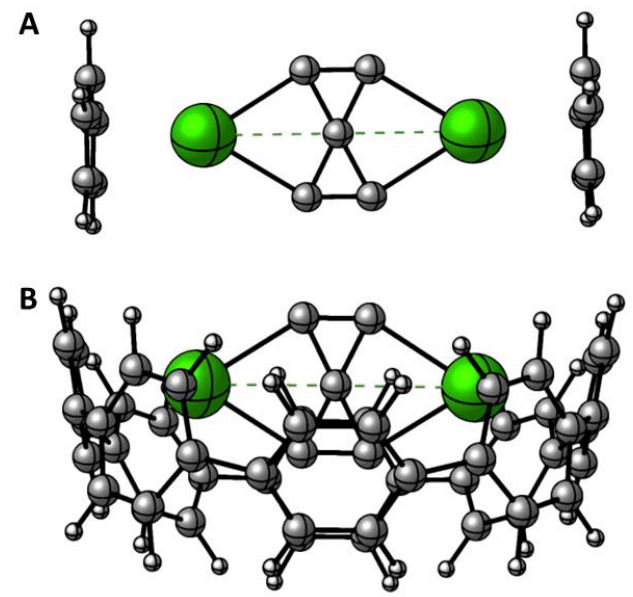
− )] 2+ and ( B ) [8-CPP] 2 − [Ca 2 [Ca 2 C 5 ]